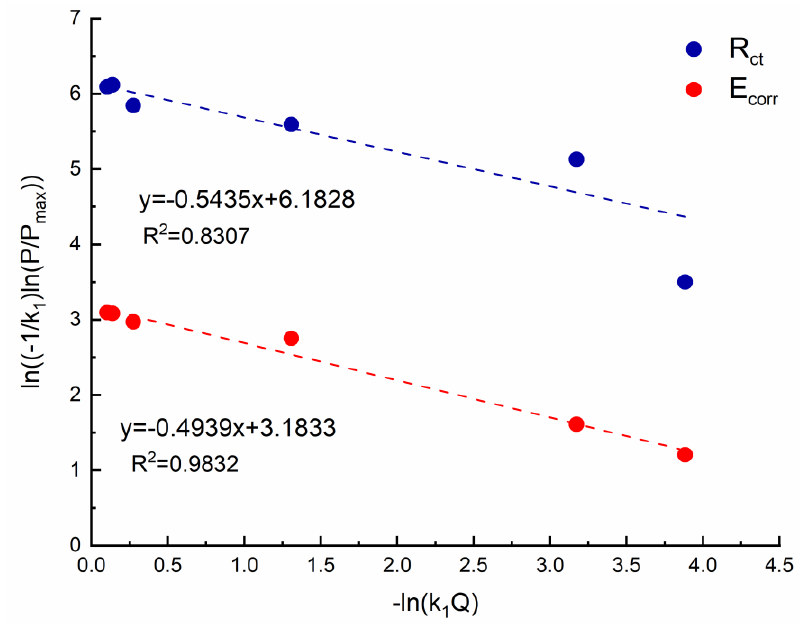
Figure 12. Fitting of experimental corrosion data to Equation (5) for AA7075-T6.